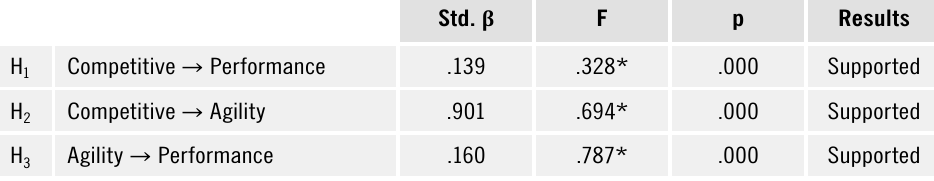
Std. β F p Results .139